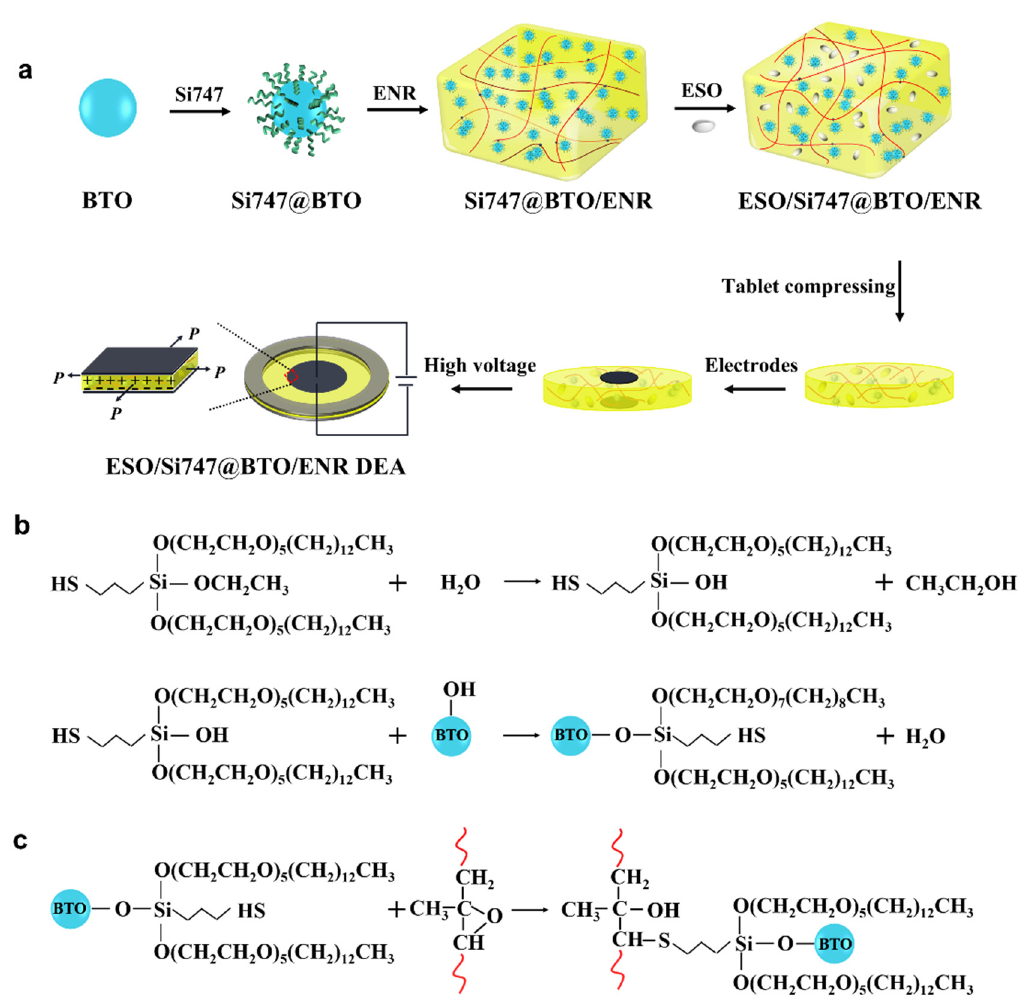
Figure 1. ( a ) Preparation and actuation mechanism of ESO/Si747@BTO/ENR DEA. ( b ) Reaction mechanism between Si747 and BTO nanoparticles. ( c ) Mechanism of Si747 reaction with ENR chains.